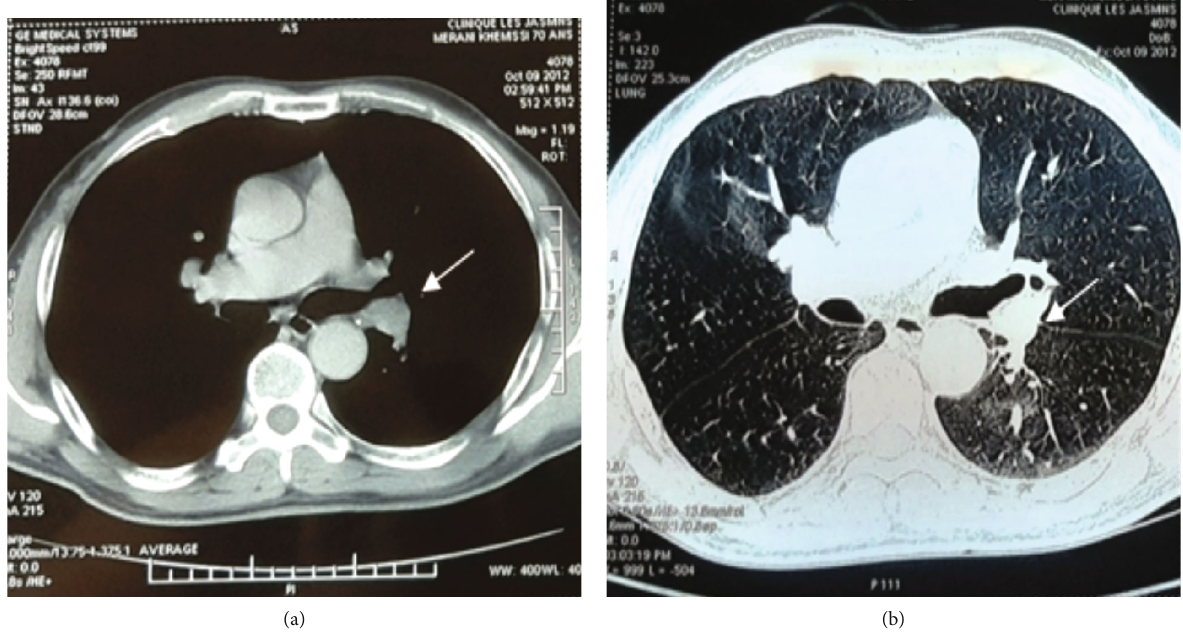
Figure 3: (a) A 3 cm dense para-aortic NPS. (b) Mediastinal window with a frosted glass appearance of